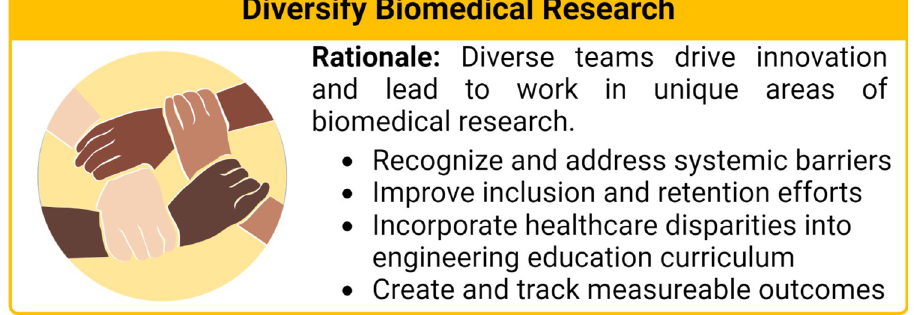
Fig 2. Rationale for diversifying biomedical research and takeaways from Rules 1 through 3. Image created with